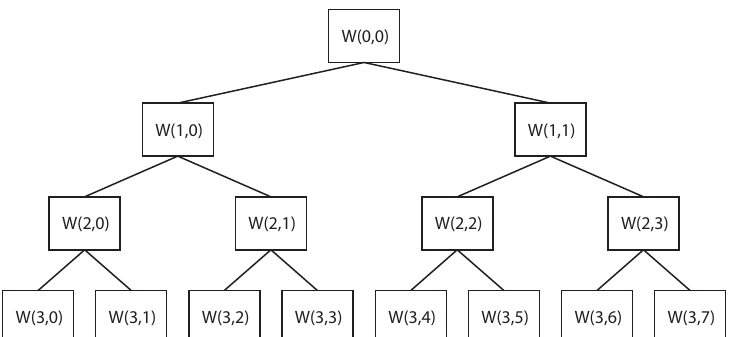
Figure 1. Wavelet Packet Transform (WPT) decomposition procedure until decomposition level 3 [20].